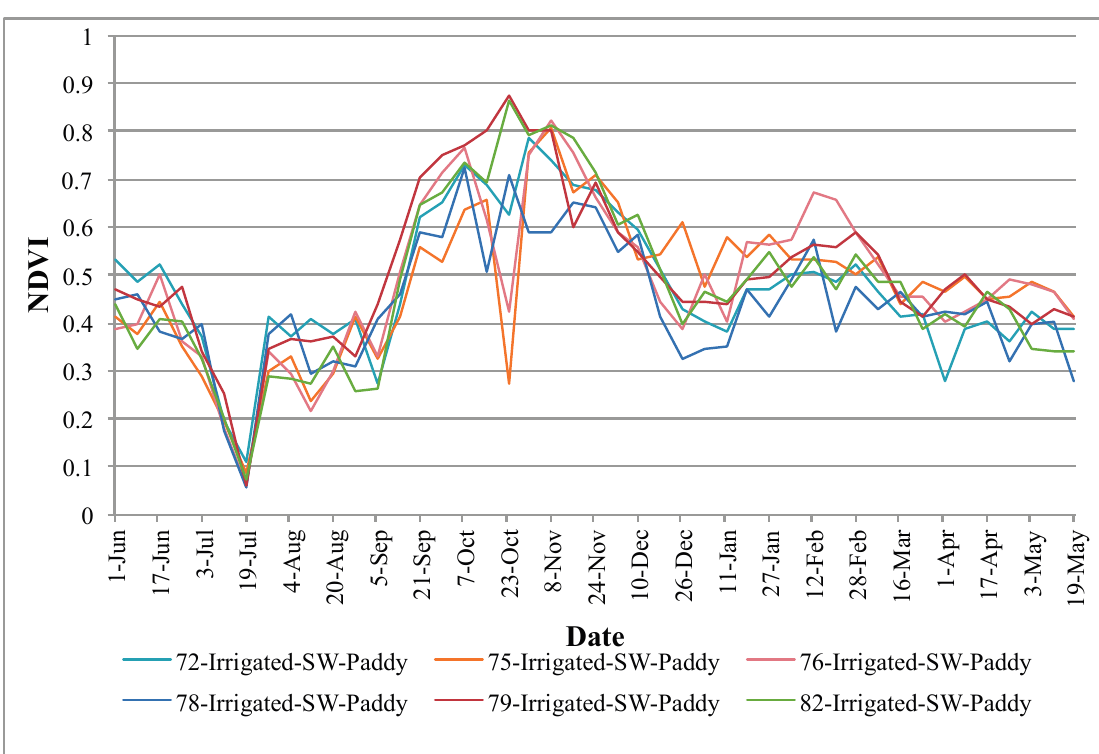
Figure 10. NDVI time series of observed rice fields, which are classified as rice pixels in the double crop rice zone.